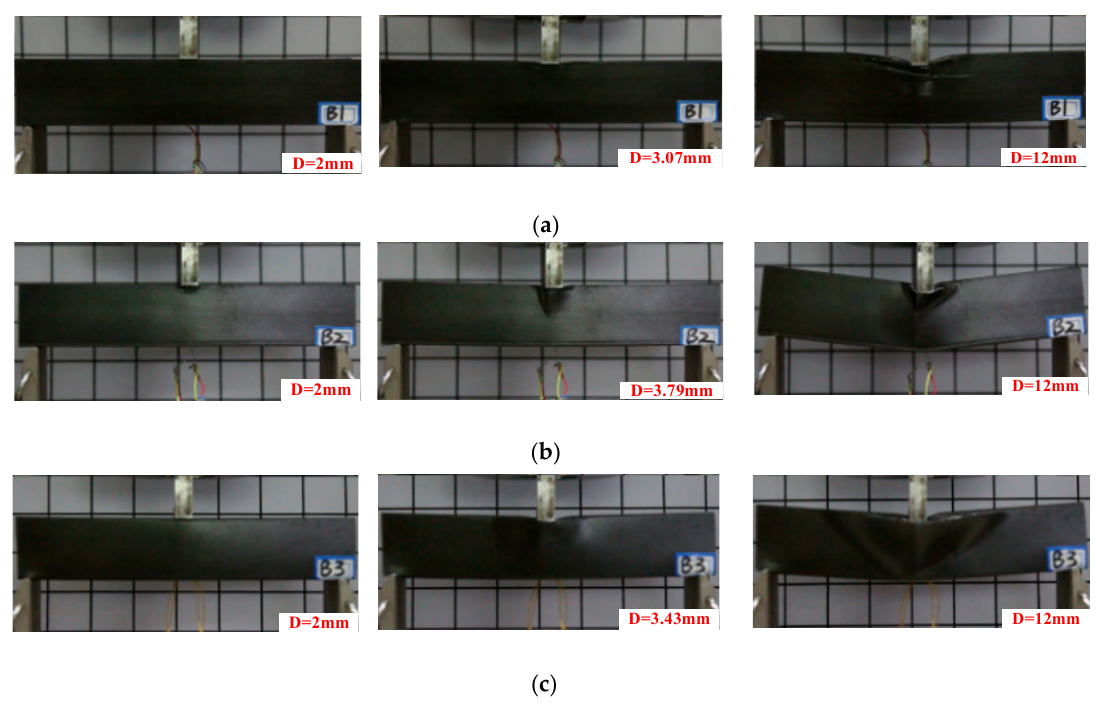
Figure 4. Three-point bending experiment process of composite sandwich laminated box beams. ( a ) Aluminum honeycomb sandwich; ( b ) Aluminum foam sandwich; ( c ) Polyurethane elastomer sandwich.